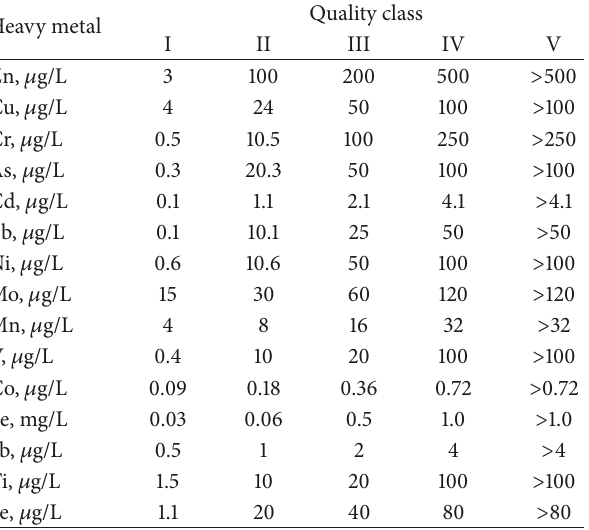
Table 2: Water quality assessment objectives of heavy metals for Voghji River